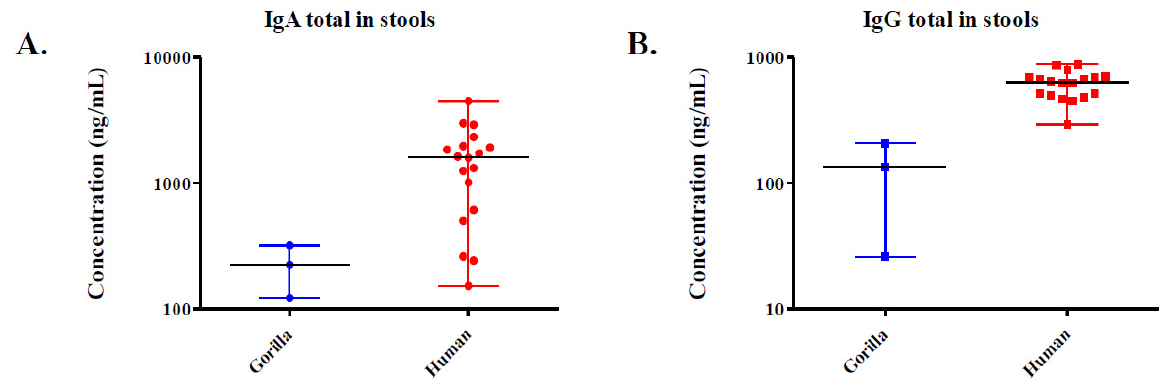
Figure 4. Evaluation of total IgA ( A ) and IgG ( B ) concentrations (ng/mL) in stools of three gorillas and nineteen humans by ELISA using the protocol 3. We used the total IgA and IgG ELISA Kits (Abcam, Paris, France).